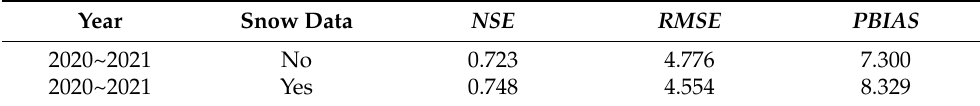
Figure 4. Simulation results of the ANN model of the Xiying River Basin from 2020 to 2021. Table 3. Evaluation parameters for the ANN model of the Xiying River Basin from 2020 to 2021.